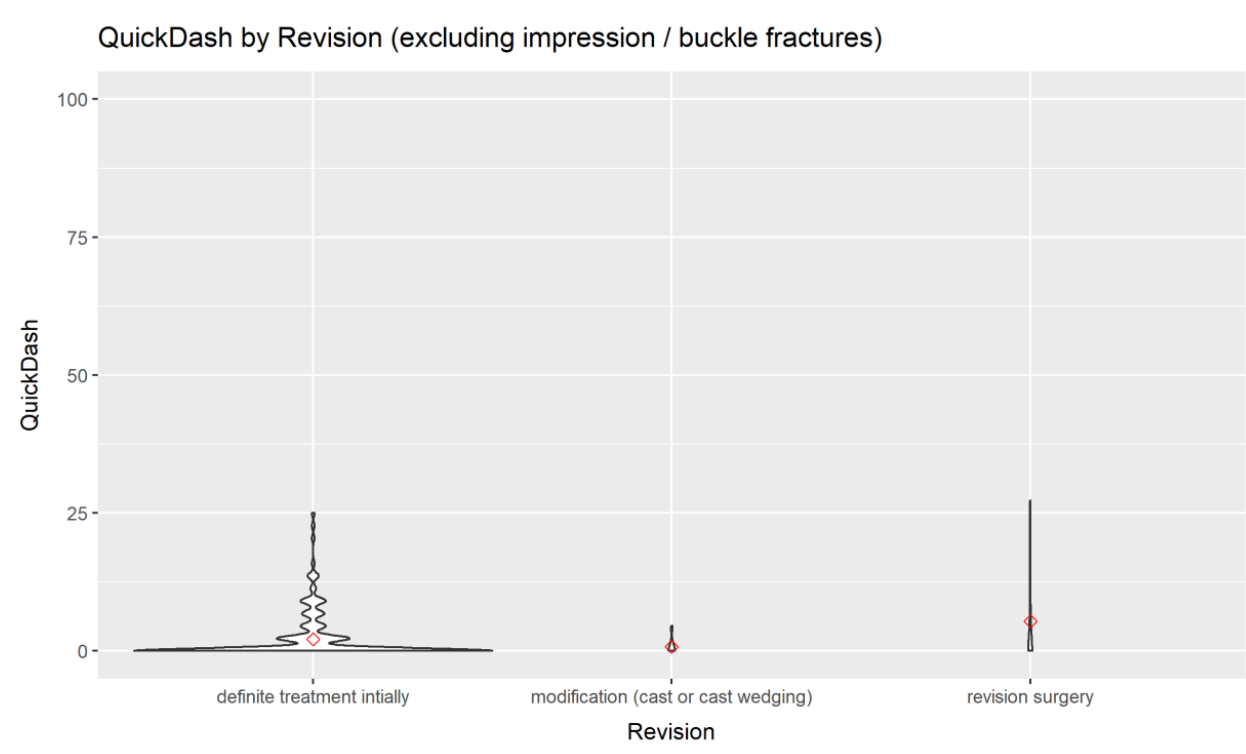
Figure 5. The primary outcome Quick-DASH at follow-up by revision. Please note that patients with impression/buckle fractures are excluded, since a revision is not performed in those fractures.